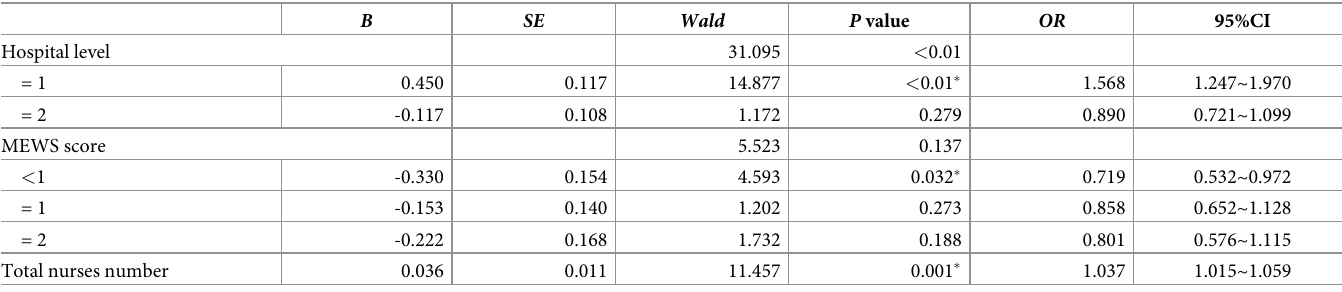
Table 4. Risk factors for patients’ favorite nurse with good nursing technology.